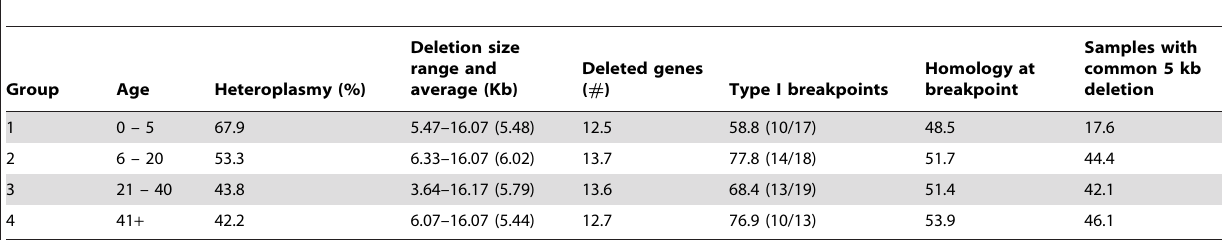
Table 1. Analysis of molecular features of mtDNA deletions in patients separated according to age groups.